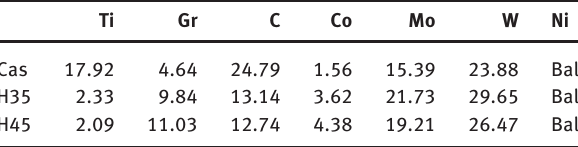
Table 3: The chemical composition (mass%) of carbides at grain boundaries in non-HIPed and HIPed